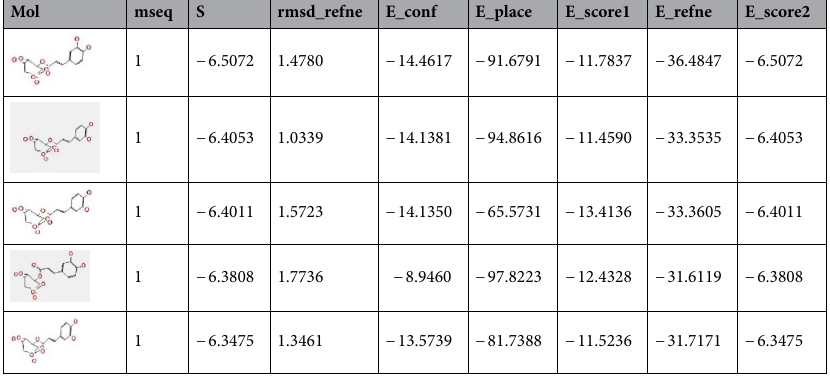
Table 8. Docking score and energies of chlorogenic acid with 1HZO receptors.